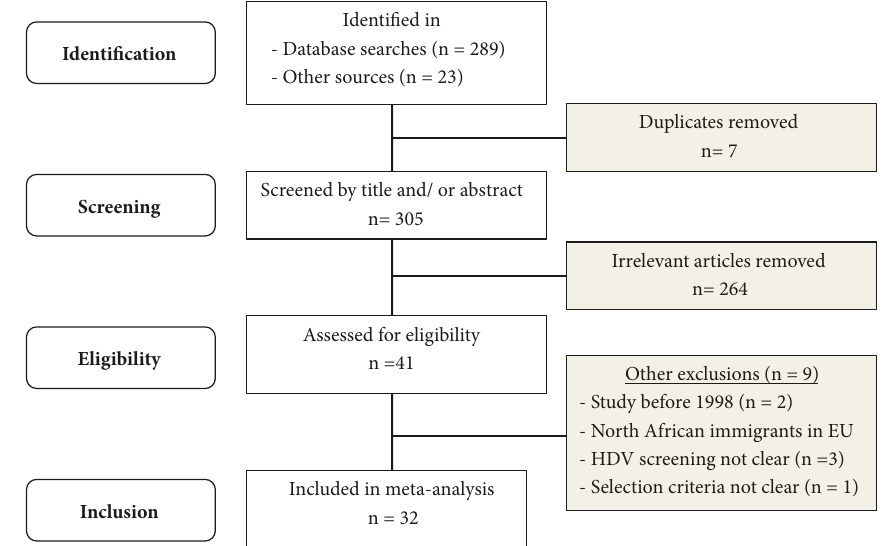
Figure 1: Flow chart of article selection for the systematic review and meta-analysis of hepatitis D virus epidemiology in North Africa (1998-